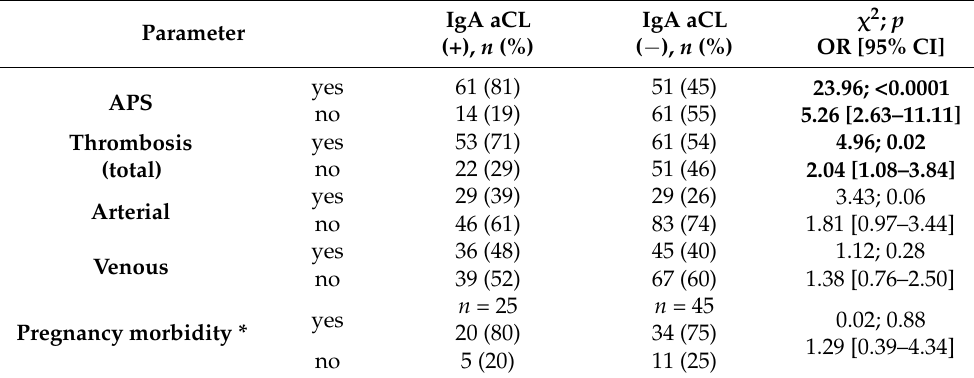
Table 1. Relationship of antiphospholipid syndrome and it is clinical manifestations (thrombosis and pregnancy morbidity) with IgA antibodies to cardiolipin (IgA aCL).